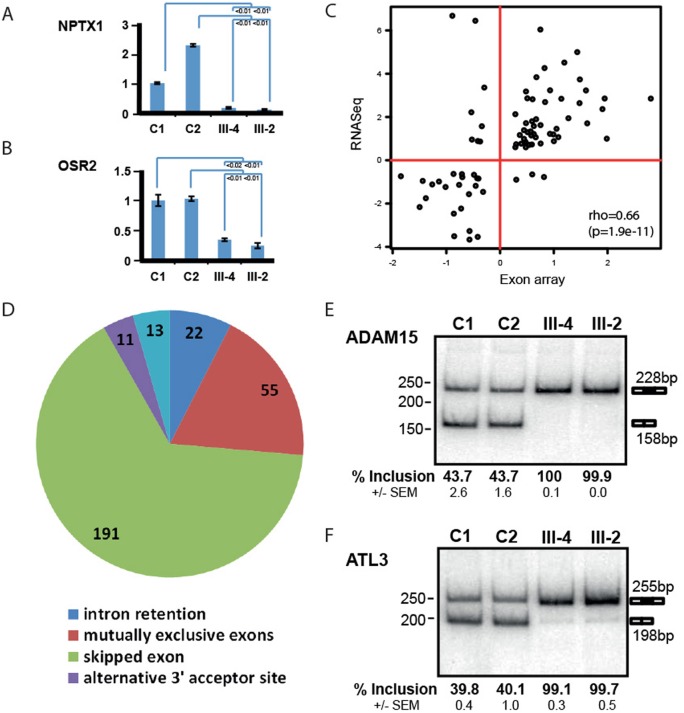
Dysregulated transcriptome in patient skin fibroblasts.(A, B) qRT-PCR validation of gene expression variation in patient cells for two illustrative examples, NPTX1 and OSR2 mRNAs. (C) Correlation analysis of differential gene expression data from exon arrays (X axis) and RNA-seq (Y axis). (D) Pie chart representing the different types of alternative splicing events detected in patient cells vs control in RNA-seq data (n = 215, p<0.01, 292 total events). (E, F) Experimental verification by RT-PCR of the splicing changes associated with INTS8 mutations for two illustrative examples ADAM15 (E) and ATL3 (F) mRNAs.